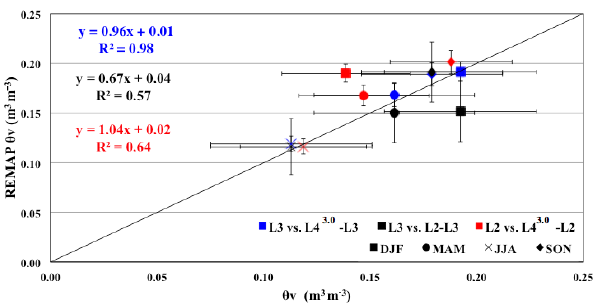
Figure 3. SMOS-derived SSM product comparison from different operational levels over the Iberian